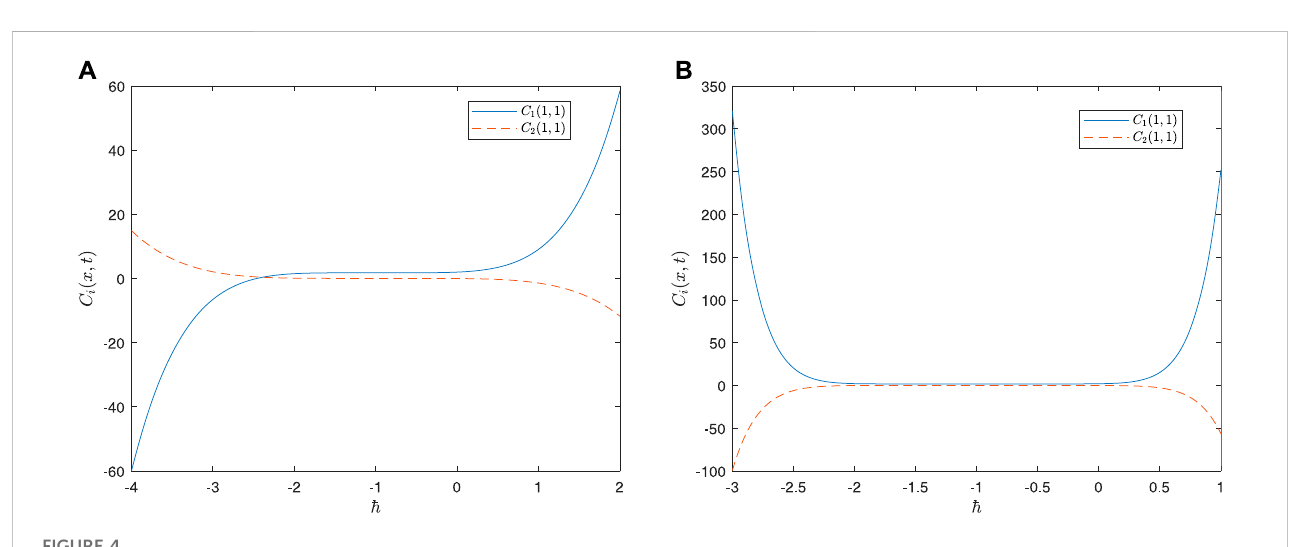
FIGURE 4 - − curves for C i ( 1 , 1 ) of the HAM solution: (A) 5 th order approximation, and (B) 10th order approximation.